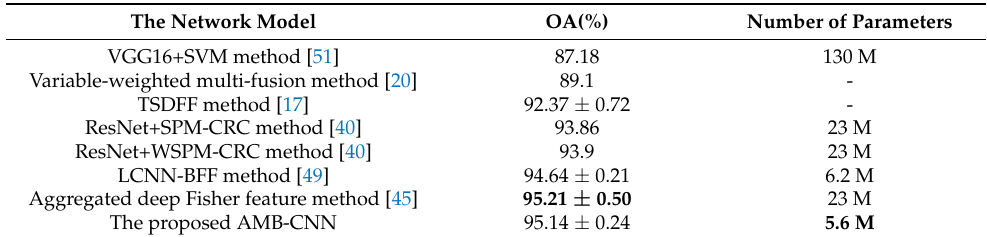
Table 3. Performance comparison of the proposed model with some state-of-the-art methods on the RSSCN7 dataset.